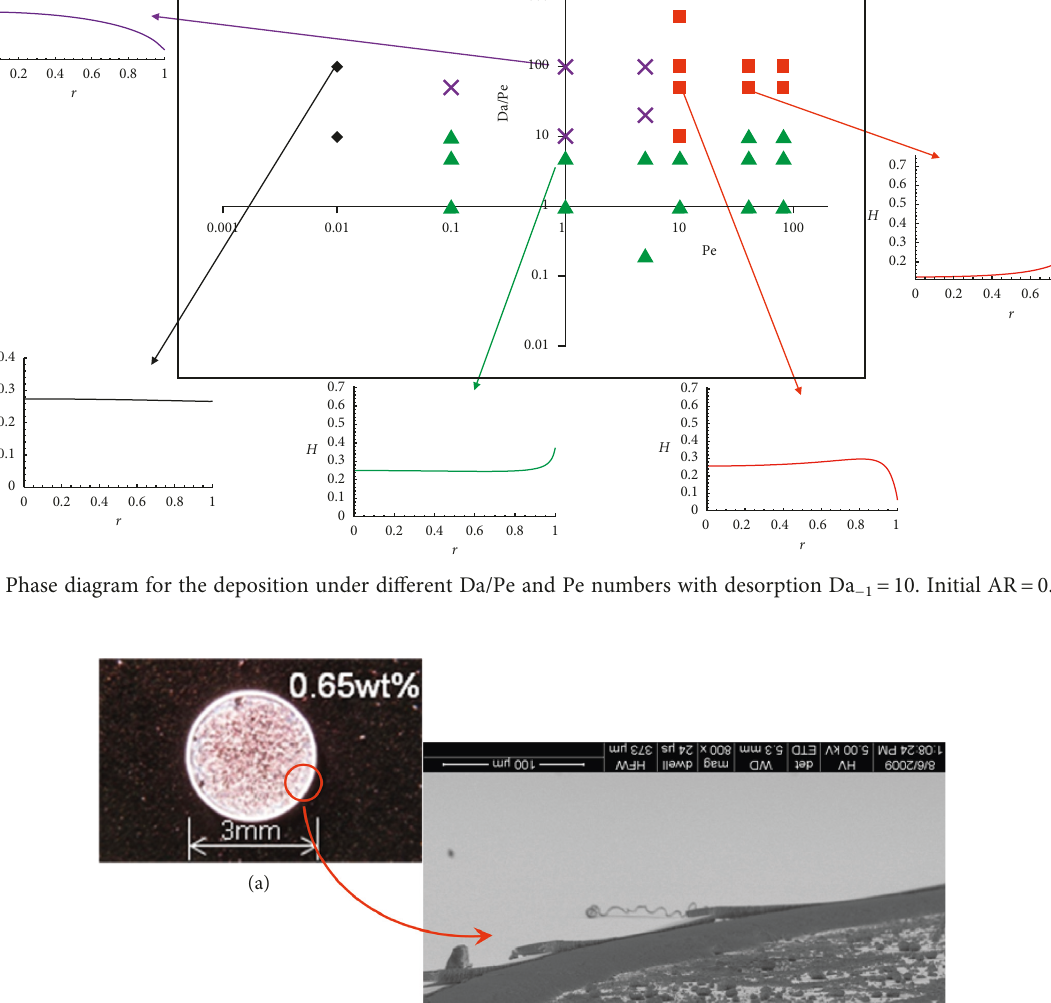
Figure 10: Final deposition profile (left column) and the particle mass versus time (right column) for the same Pe and Da but different Da (a) Pe � 10, Da � 50, Da − 1 � 0; (b) Pe � 10, Da � 50, Da − 1 � 10; (c) Pe � 10, Da � 50, Da − 1 � 50. Initial AR � 0.5, H � 0.5.